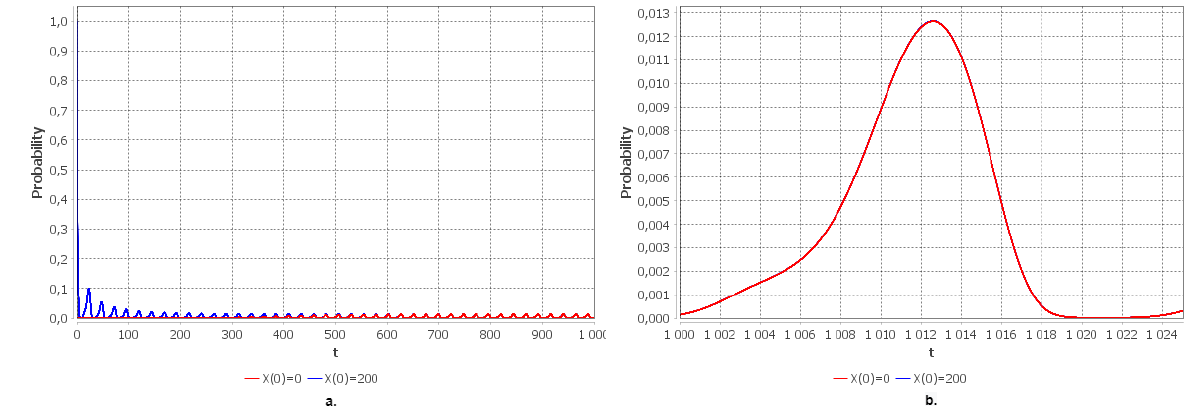
Figure 4. ( a ) Probability of blocking for t ∈ [ 0,1304 ] . ( b ) Approximation of the limiting probability of blocking for t ∈ [ 1304,1329 ] .